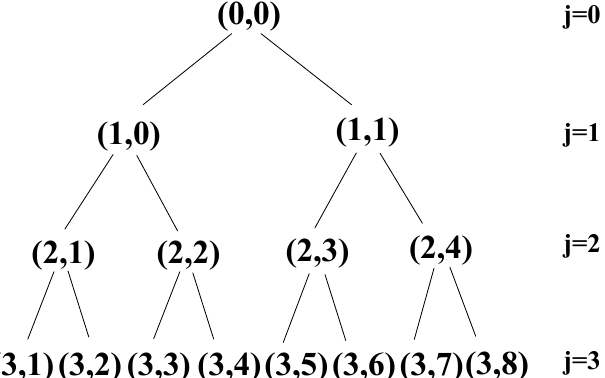
Figure 3. Structure of the three-layer wavelet packet decomposition for reconstruction of cutting force signals. Wavelet packet decomposition (WPD) is a time-frequency analysis method. In WPD, the scale ( ) x ψ function of a standard orthogonalization is used, and with two scale difference recursive Equations, the orthogonal wavelet packet is generated as =